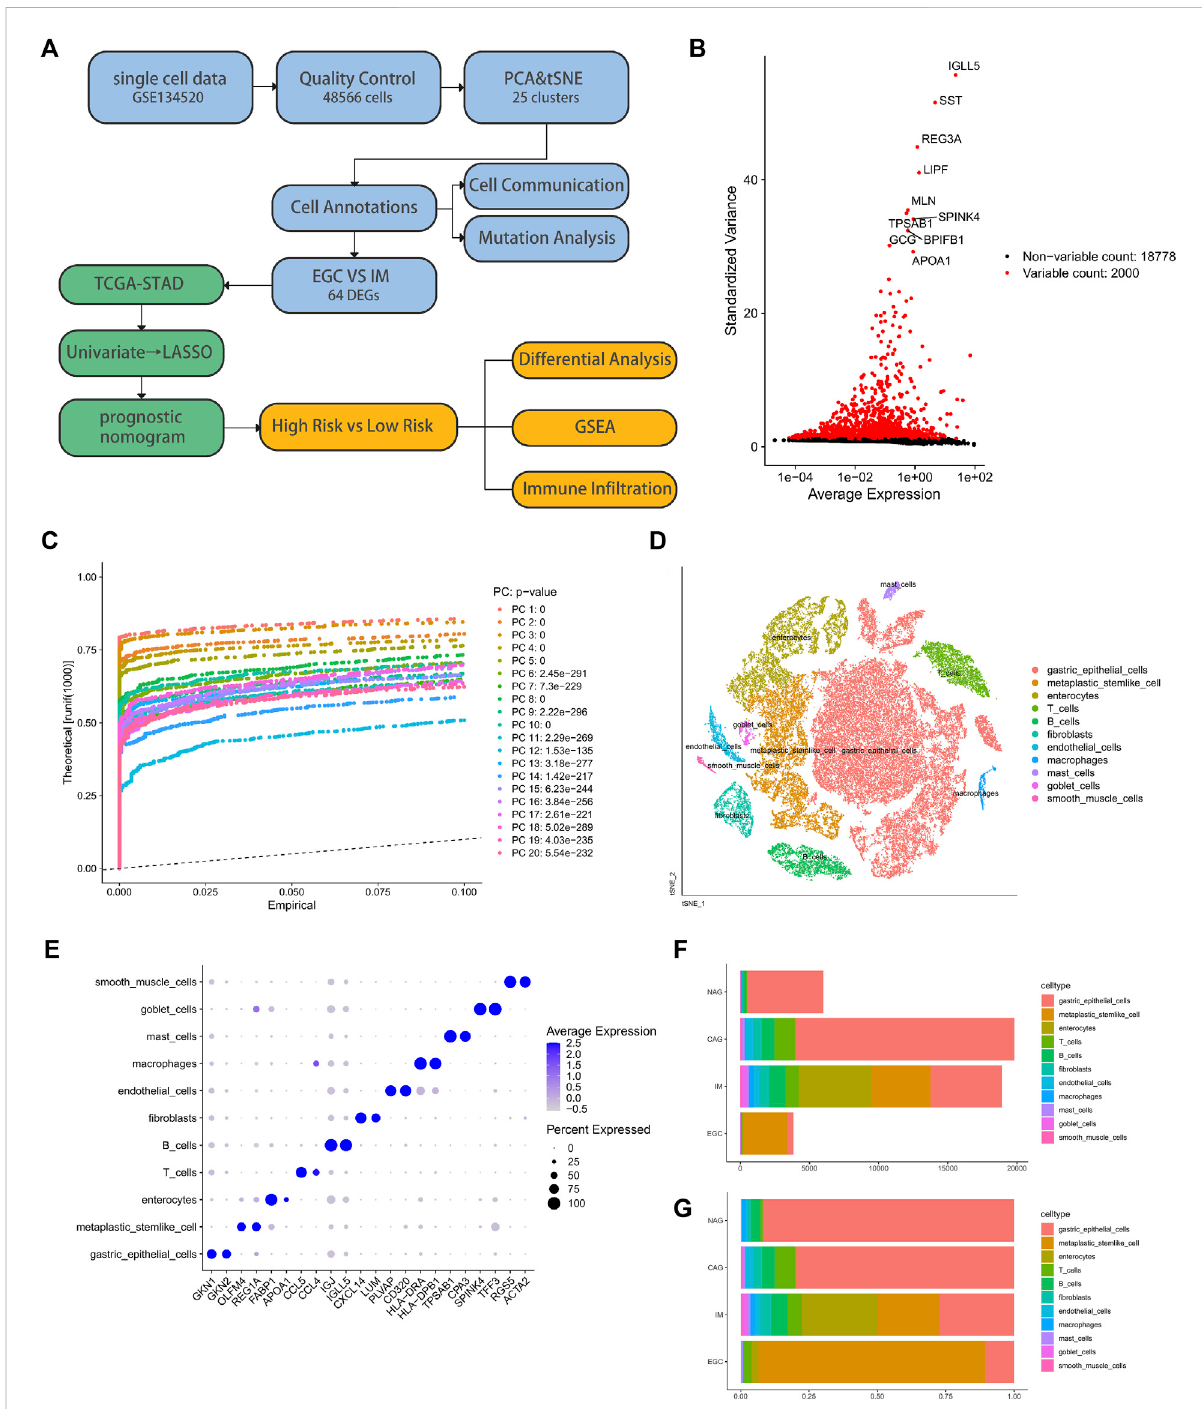
FIGURE 1 Analysis of the biopsy specimens from the gastric antral mucosa of patients with non-atrophic gastritis (NAG), chronic atrophic gastritis (CAG), intestinal metaplasia (IM), or early gastric cancer (EGC) based on single-cell RNA-seq data. (A) Flow chart of the study. (B) Scatter plot of standard deviation demonstrated the signi fi cantly differentially expressed genes between the cell types. (C) JackStrawPlot of 20 principal components ( p value < 0.01) used to fi nd clusters. (D) Cluster analysis based on the distribution of different cell types. (E) Prominent marker genes for each cell type. (F) and (G) Number of each cell type and the proportion of cells per cell type in the samples of the four different disease